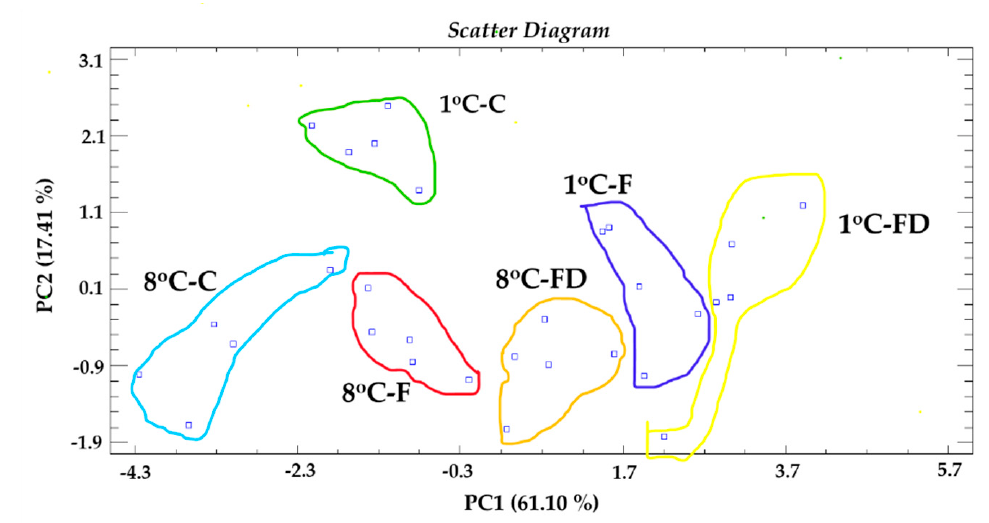
Figure 3. A principal component analysis applied to the different treatments (1 °C-C, 1 °C-F, 1 °C-FD, 8 °C-C, 8 °C-F and 8 °C-FD). Two principal components (PC1 and PC2) resulted in a model that explained 78.5% of the total variance.